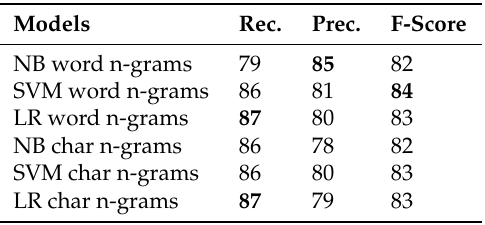
Table 3. Comparison of classification